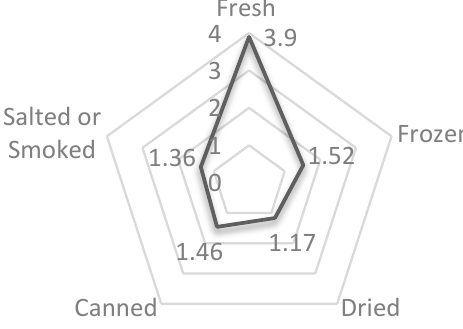
Figure 3. Fish consumption preferences.